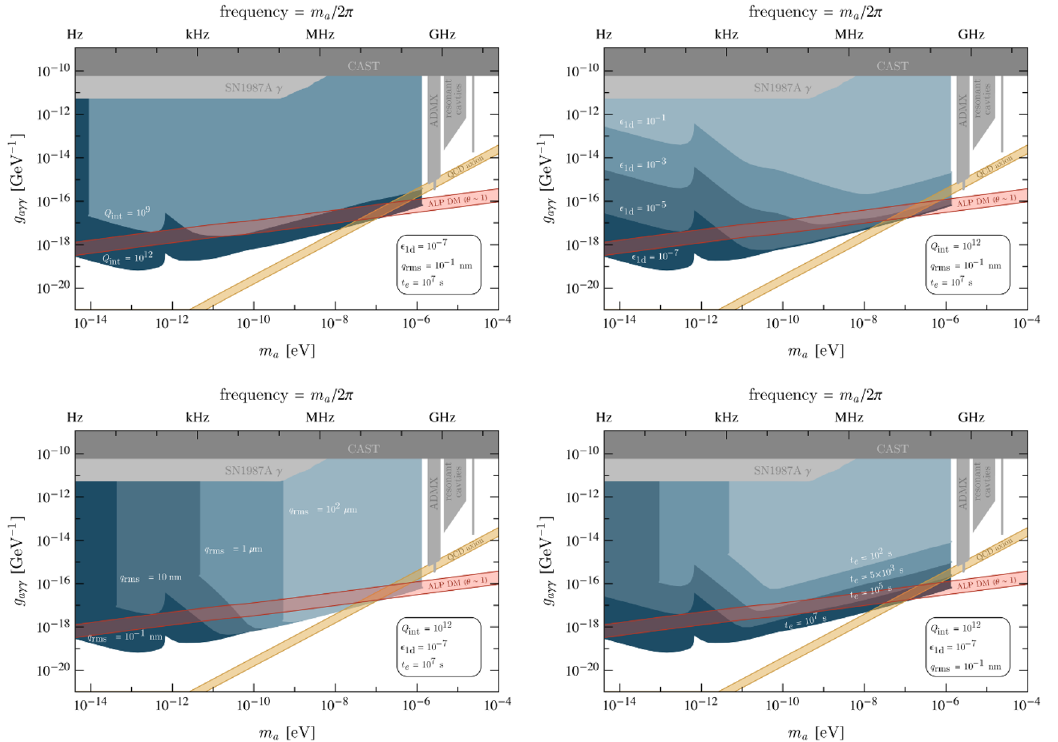
Figure 5 . The anticipated reach to axion dark matter in the g experimental parameters. Our baseline parameters are those of the lower curve of (cid:12)gure 2, including Q int = 10 12 , (cid:15) 1d = 10 (cid:0) 7 , q rms = 10 (cid:0) 1 nm, and t e = 10 7 s. In each panel, we vary one of